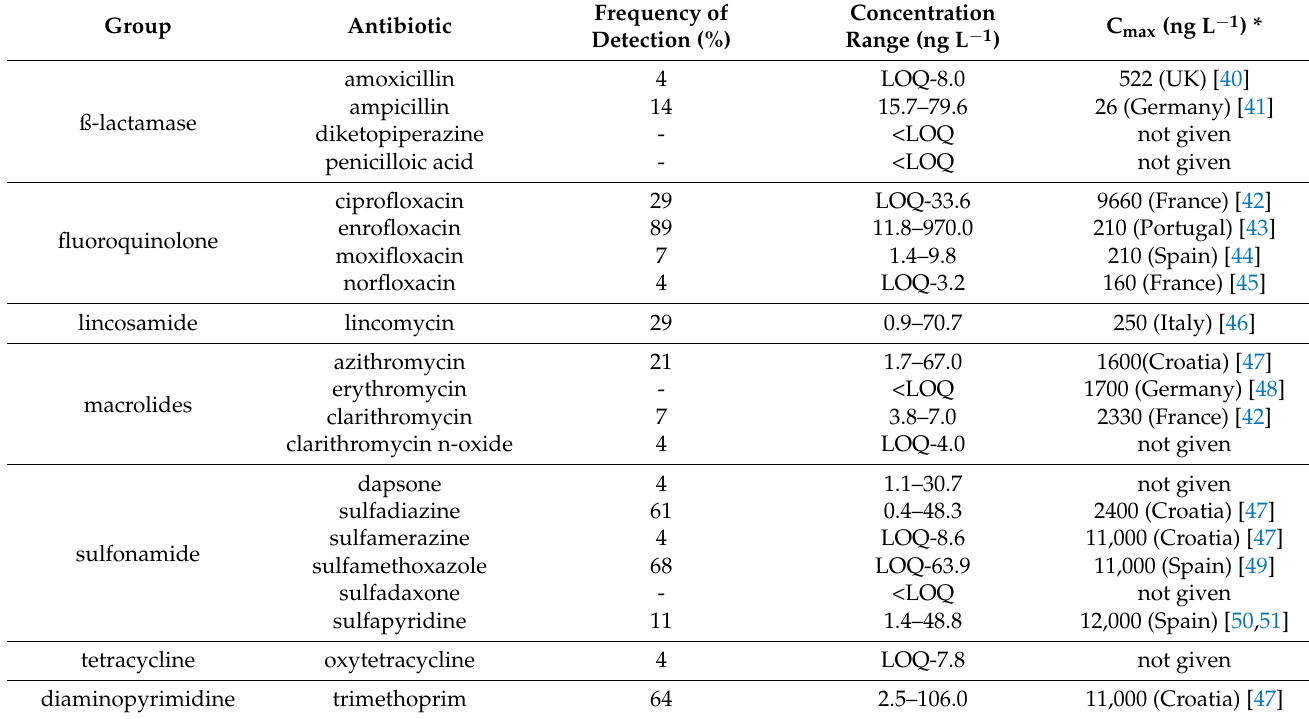
Table 2. Frequency of the detection and concentration range of target antibiotics in surface waters in comparison with the maximum concentration reported in